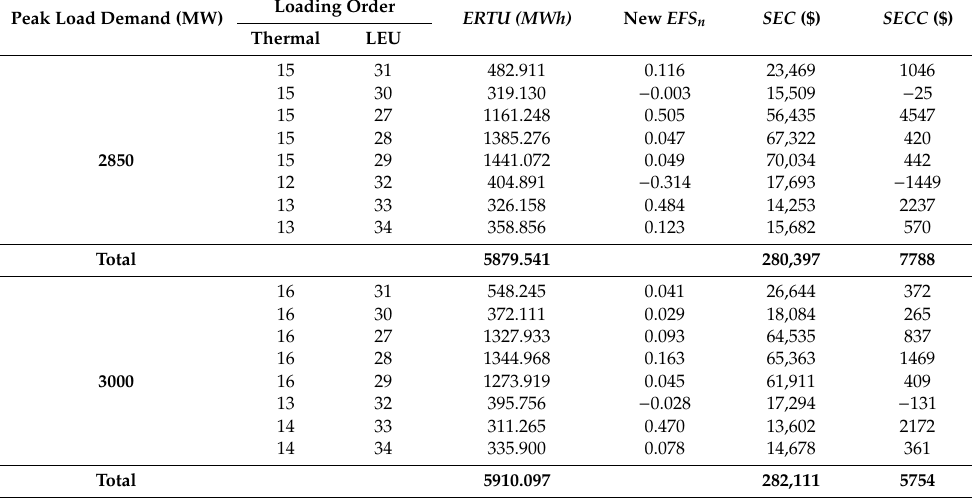
Table 4. The results of the objective function of the SUC determined by using the proposed method of the MABC-NSM for the peak-load demands of 2850 MW and 3000